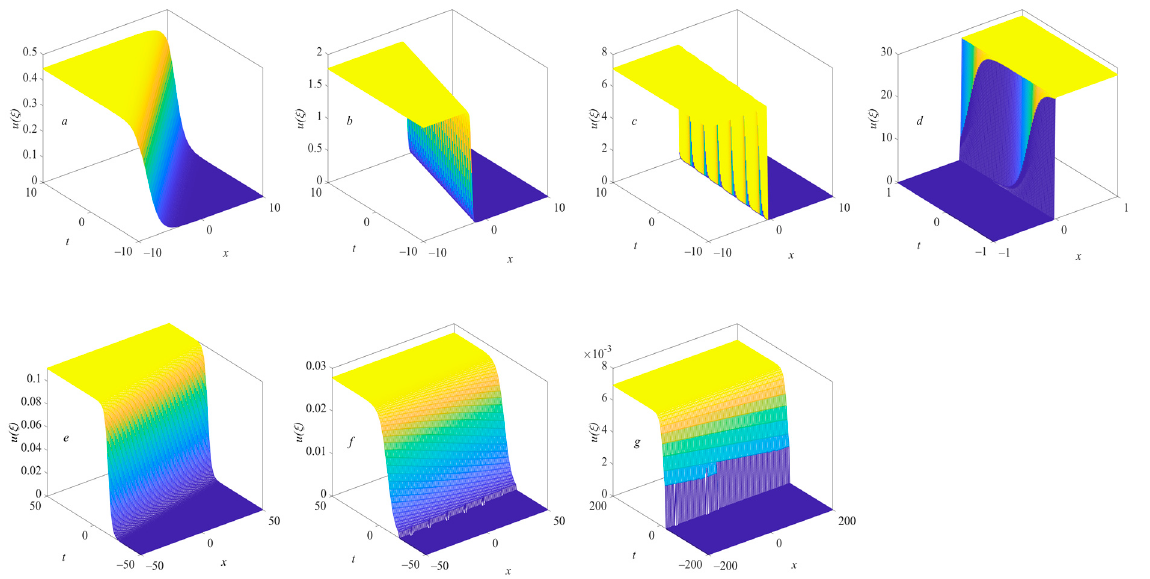
Figure 7. Evolution of solitary waves with n in u 7 n when k = 1, λ = 1, ν = 1, ε = 1, r = 1: ( a ) n = 1, ( b ) n = 2, ( c ) n = 4, ( d ) n = 8, ( e ) n = 1